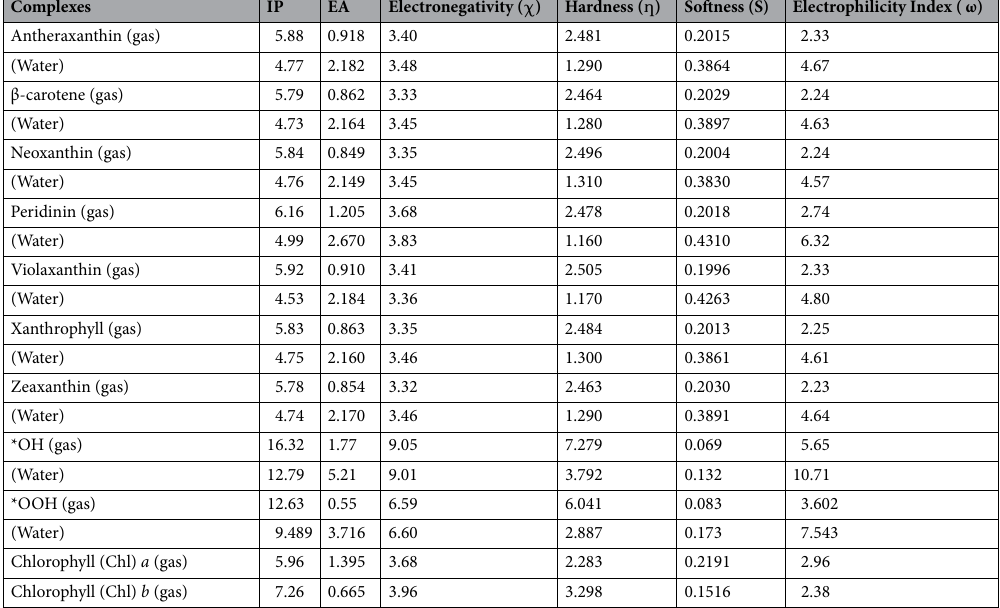
Table 1. Calculated IP, EA, Global reactivity descriptors—electronegativity ( χ ), global hardness ( ƞ ), global softness (S) and electrophilicity index (ω) in (eV) for studied carotenoid and Chlorophyll complexes with wB97xD/6-31G** and wB97xD/Lanl2dz6-31G** method respectively by DFT. *OH and *OOH parameters are taken from Ref. 41